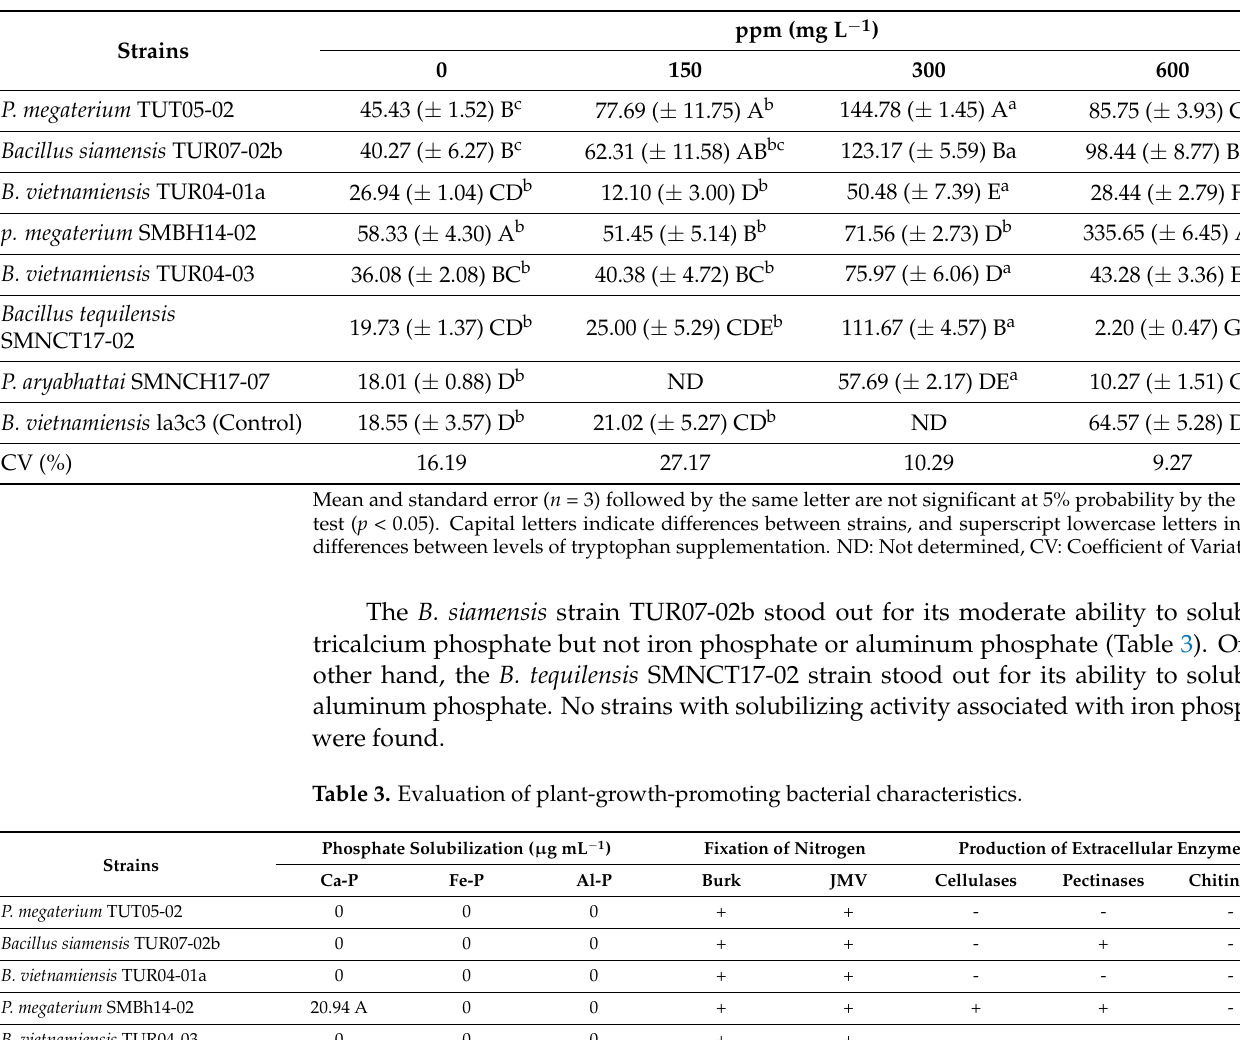
Table 2. Evaluation of the production of indole compounds by endophytic rice bacteria at four concentrations of supplemented tryptophan ( µ g IAA mL − 1 ).